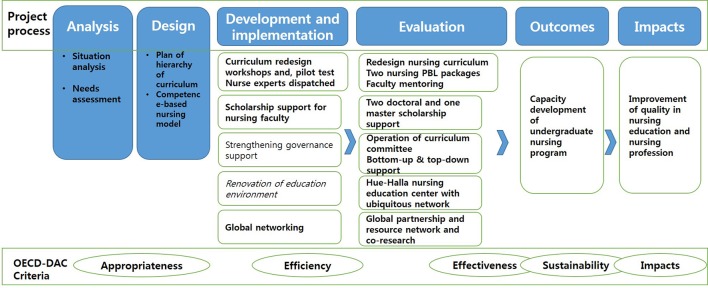
Project process.